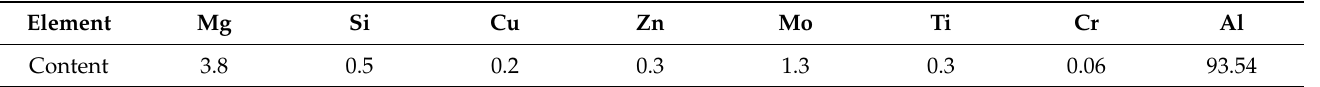
Table 3. Chemical composition of 5083 aluminum alloy (wt.%).